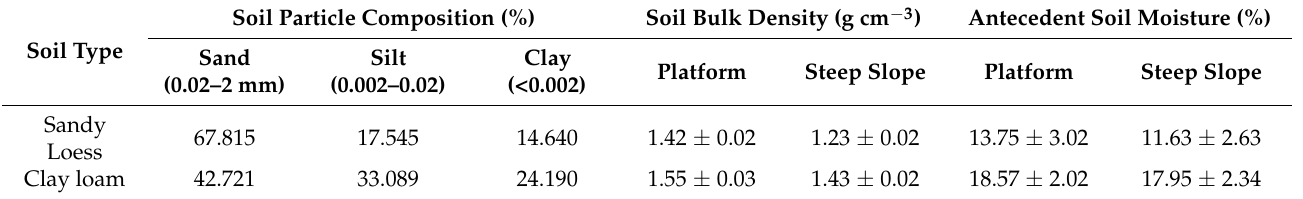
Table 1. Physical properties of experimental